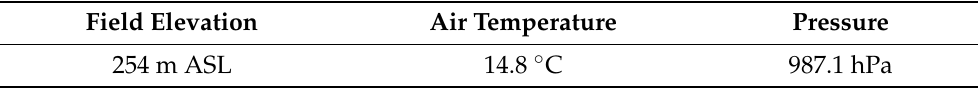
Table 8. Turin flight environment